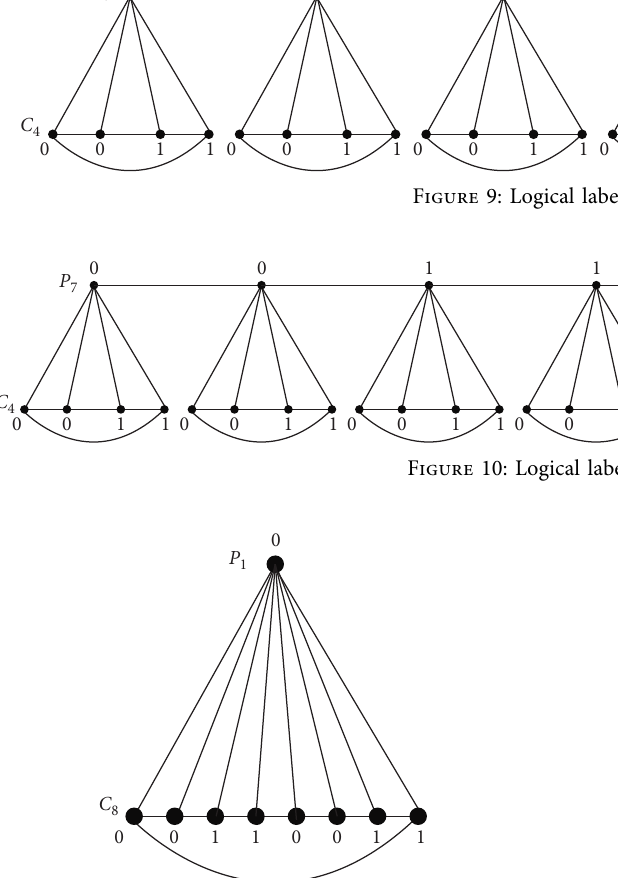
Figure 11: Logical labeling of P